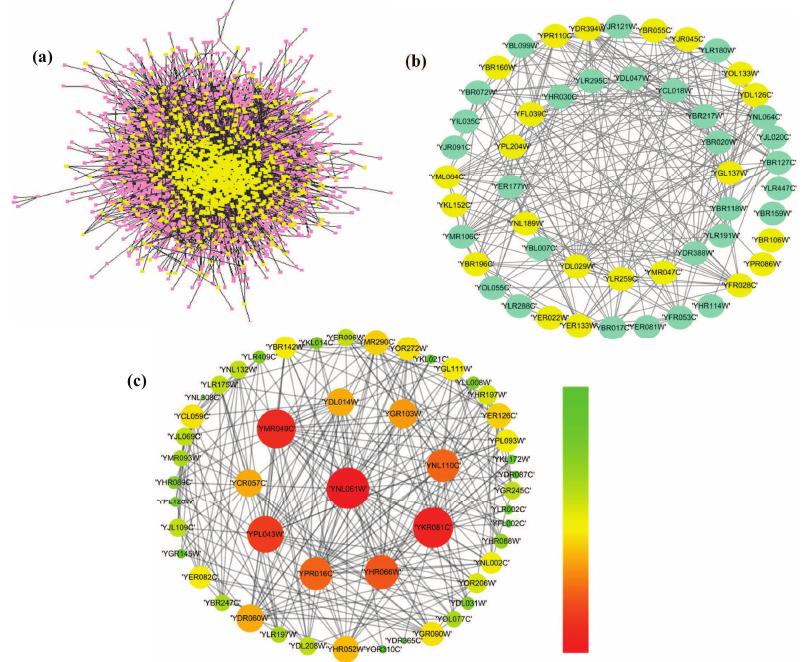
Figure 7. The distribution of essential proteins: ( a ) the identified top 1% essential proteins by DC; ( b ) the identified top 1% essential proteins by DC, where yellow circles are the essential proteins that DC predicted as essential, while aqua circles are the non-essential proteins that DC predicted as essential ones; and ( c ) the identified top 1% essential proteins of HSEP, where the larger is the degree of the protein, the bigger is the size of the protein.The color key indicates that the degree of protein gradually increases from top to